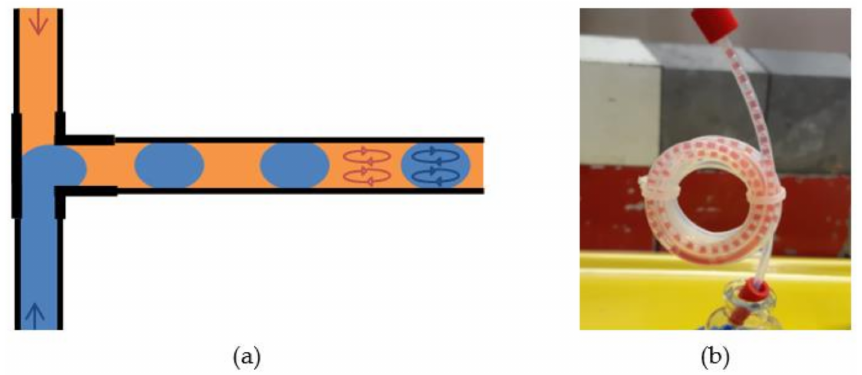
Figure 3. ( a ) Operating principle with schematic representation of internal circulation within the two phases and ( b ) photo of a slug-flow regime in the loop in which the organic phase has been colored red by adding a